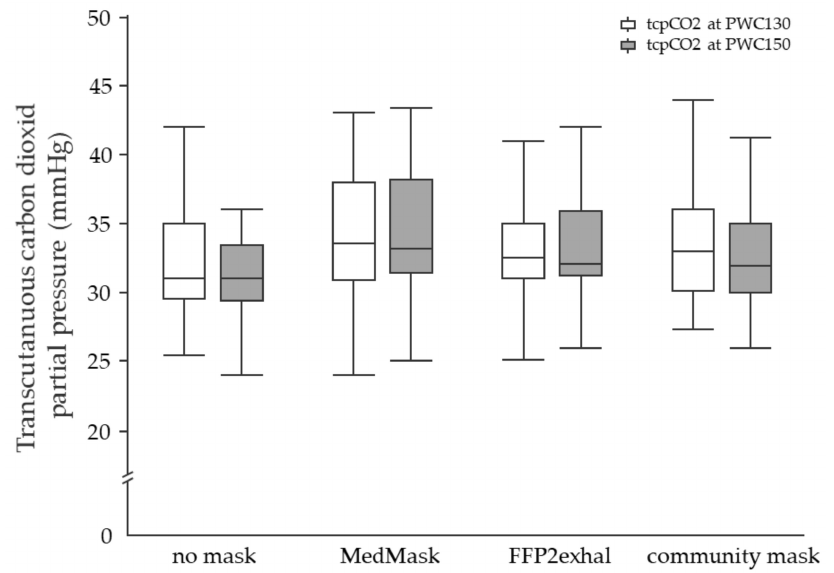
Figure 3. Transcutaneous carbon dioxide partial pressure at the heart rate of 130 and 150 beats per minute using different face masks. Grey shaded boxplots represent the tcpCO2 at PWC150. tcpCO2, transcutaneous carbon dioxide partial pressure; PWC, physical working capacity; MedMask, medical face mask; FFP2exhal, filtering facepiece with exhalation valve.